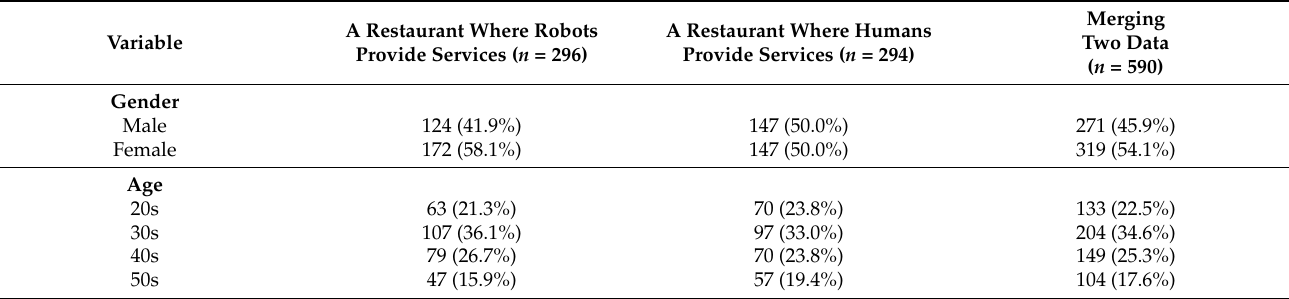
Table 1. Profile of survey